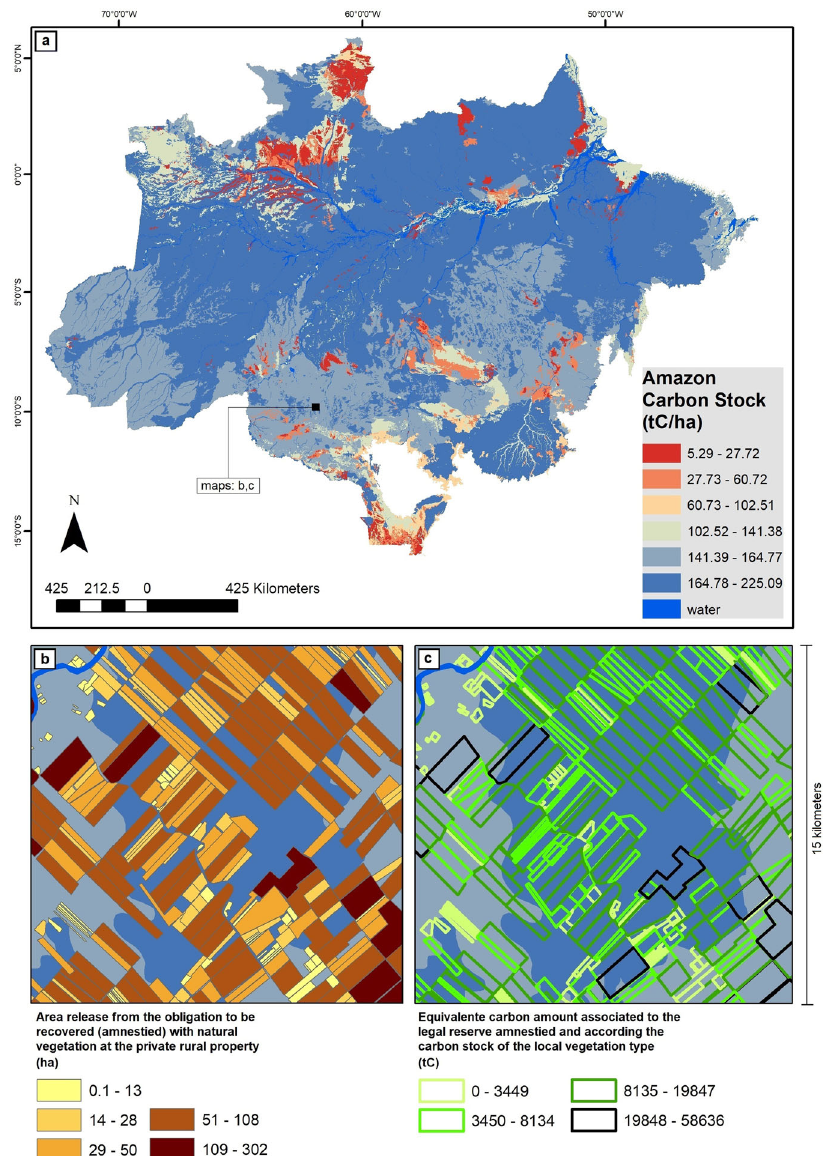
Fig. 3 Spatial distribution of small private rural properties and reference values for carbon stocks according to natural vegetation types in the Amazon biome. a The Amazon biome map shows the carbon stocks (tC/ha — i.e., total carbon stock: above- and below-ground, litter, and dead wood) per vegetation type that naturally occurs across the region [see “ Methods ” for a description of the procedures used]; b the polygons represent small rural properties in the Amazon and the colors of each polygon indicate the area (ha) that the property was in LR de fi cit but amnestied; c the colors of each polygon (i.e., private property) represent the equivalent amount of carbon that would be potentially stored in natural vegetation cover if it was recovered. Color slices in these maps were created using Natural Breaks